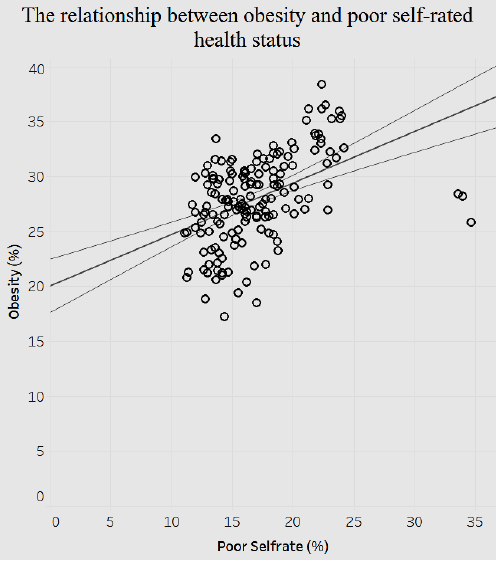
Figure 18. Obesity by poor self-rated health status.